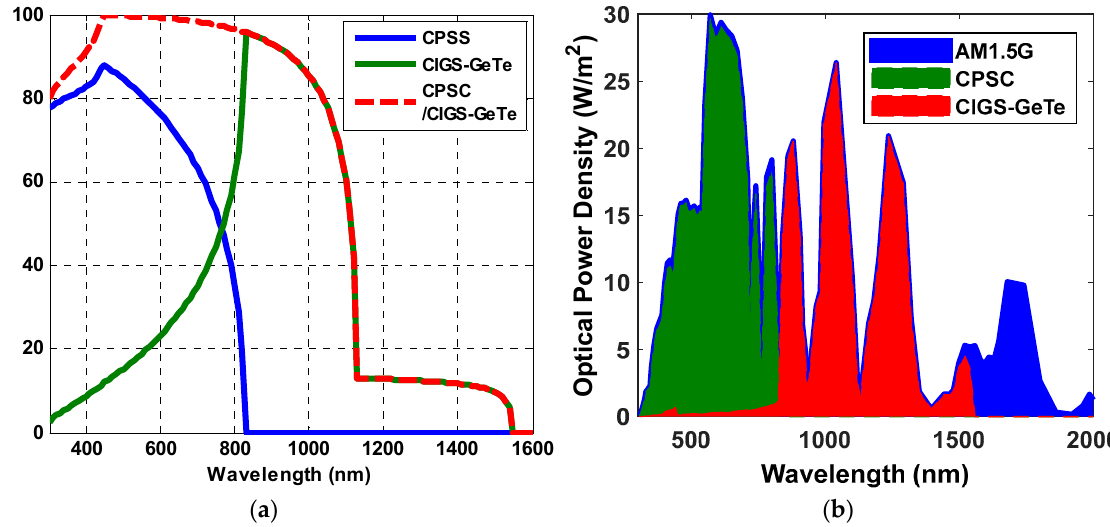
and ( b ) JV curves of CPSC/CIGS-GeTe sub-cells besides the tandem solar cell.